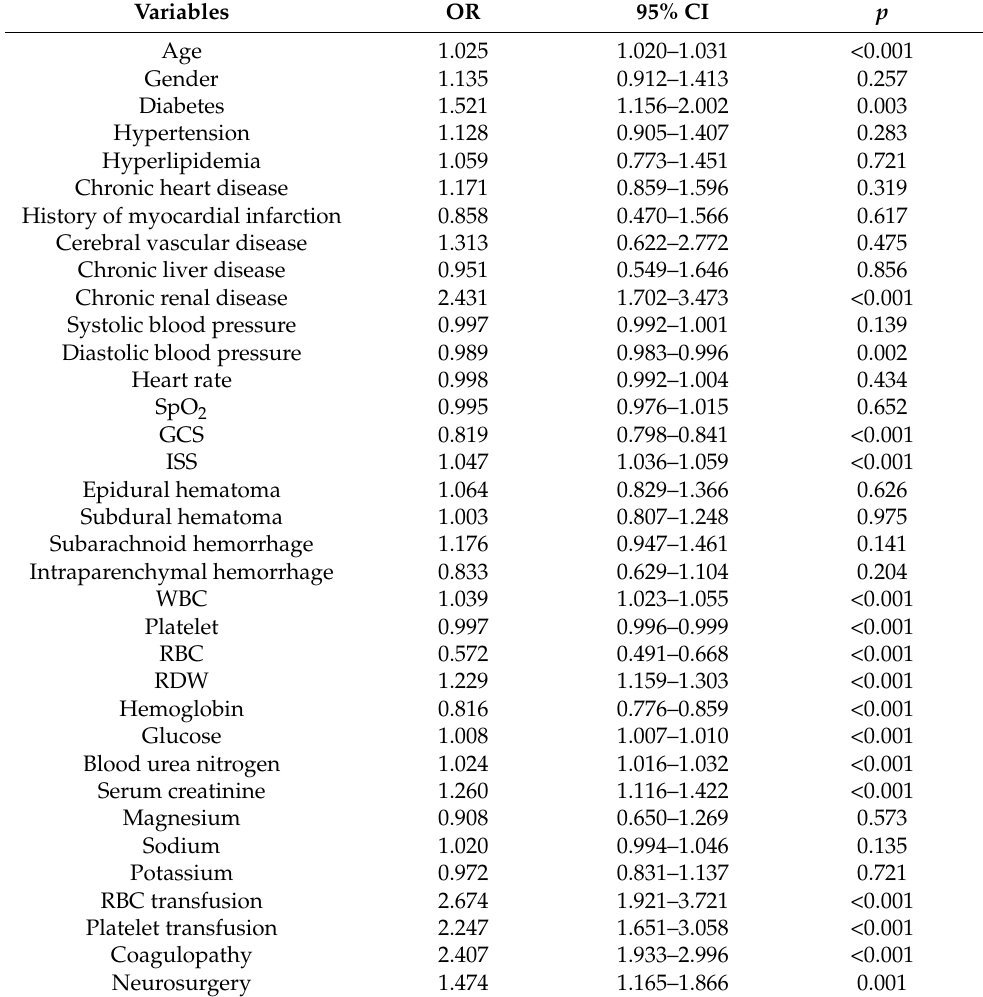
Table 2. Univariate logistic regression analysis of risk factors for coagulopathy in TBI